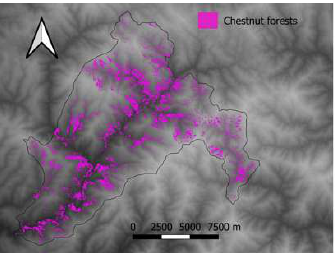
Figure 4. Chestnut mapping results obtained with Model 5. Background image: DTM (Digital Terrain Model) 5 m obtained from the Spanish Cartographical Institute (IGN, 2019).